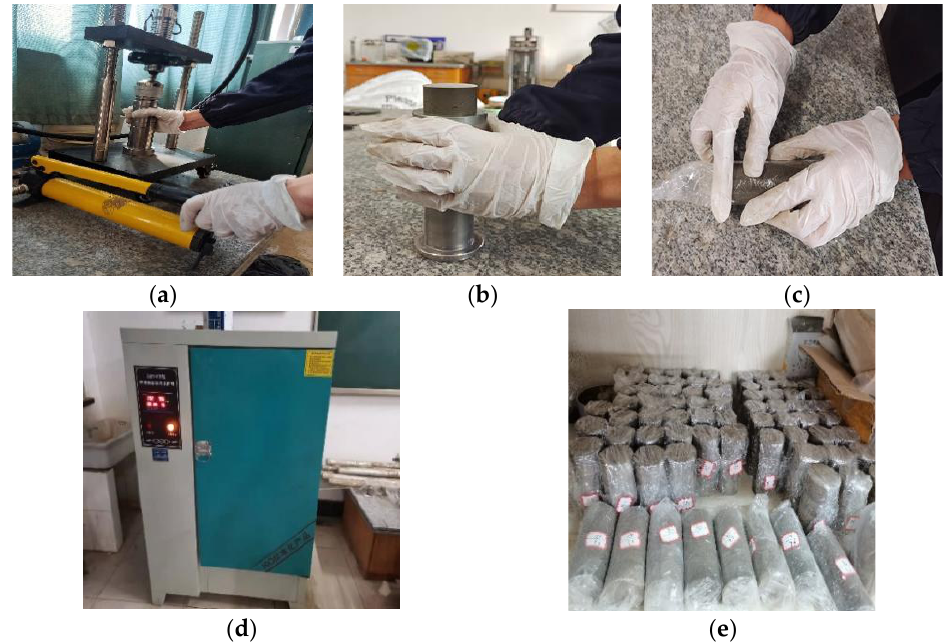
Figure 6. Static pressure specimen preparation steps of ( a ) compressing soil, ( b ) specimen taking out, ( c ) specimen packaging, ( d ) specimen curing, ( e ) formed specimen.